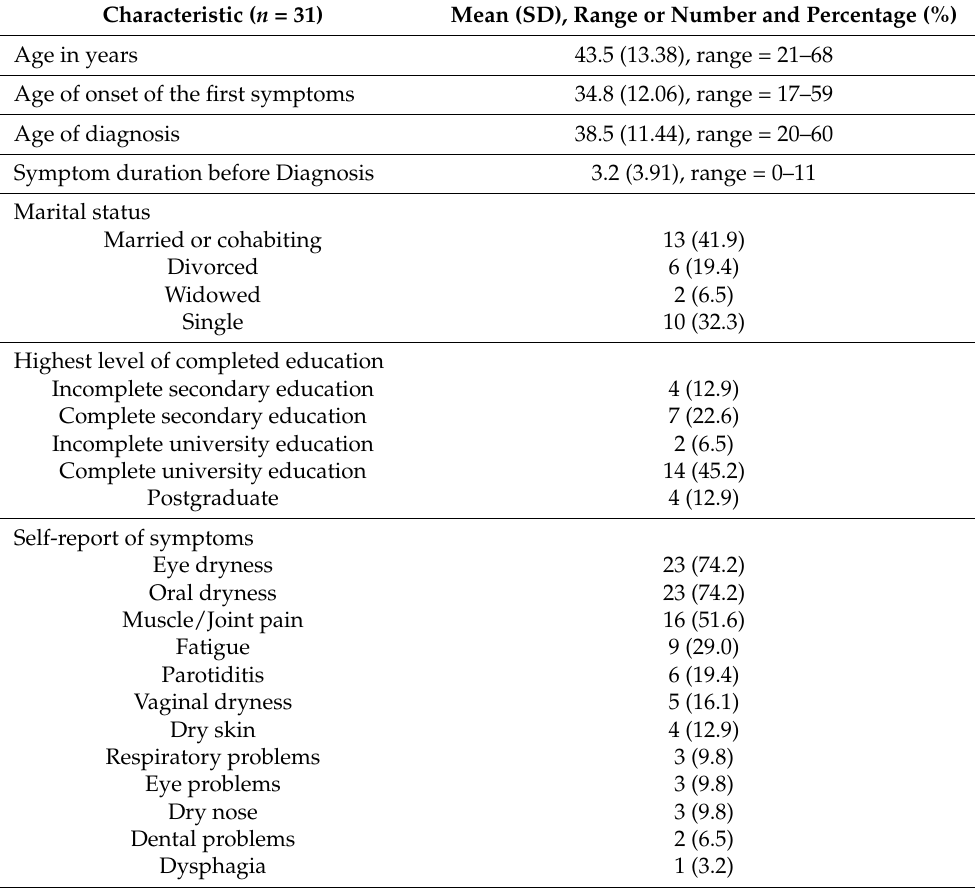
Table 1. Characteristics of the